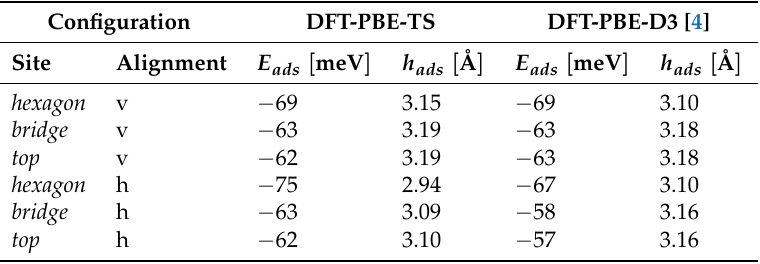
Table 3. Adsorption energies of the H 2 molecule on the three adsorption sites in all here considered configurations (see Figure 1, x- and y-alignments yield the same behaviour and are labelled h). DFT-PBE-D3 values are taken from Ref.